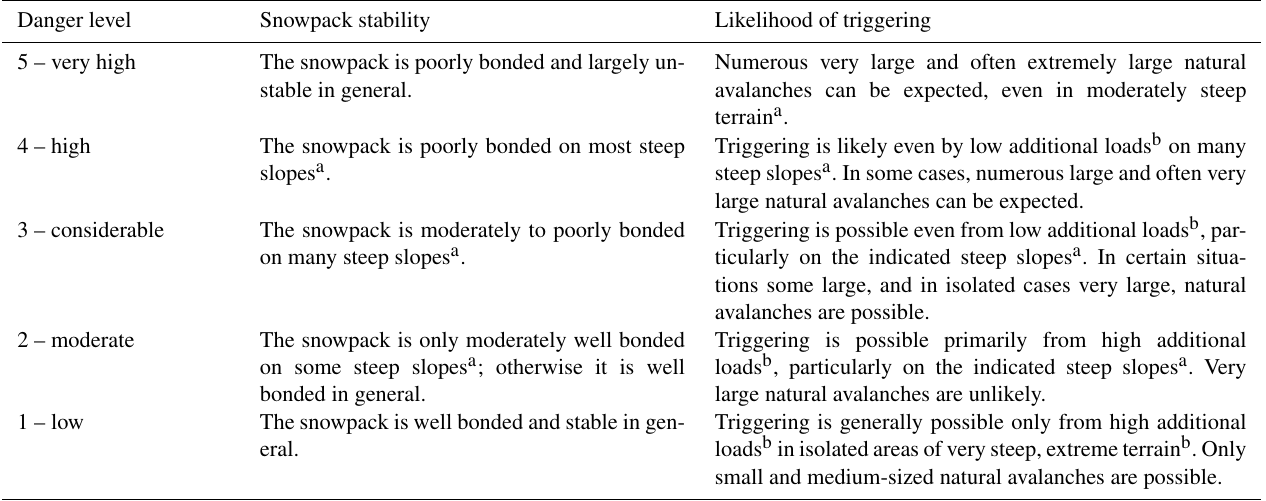
Table 1. European Avalanche Danger Scale (EAWS,